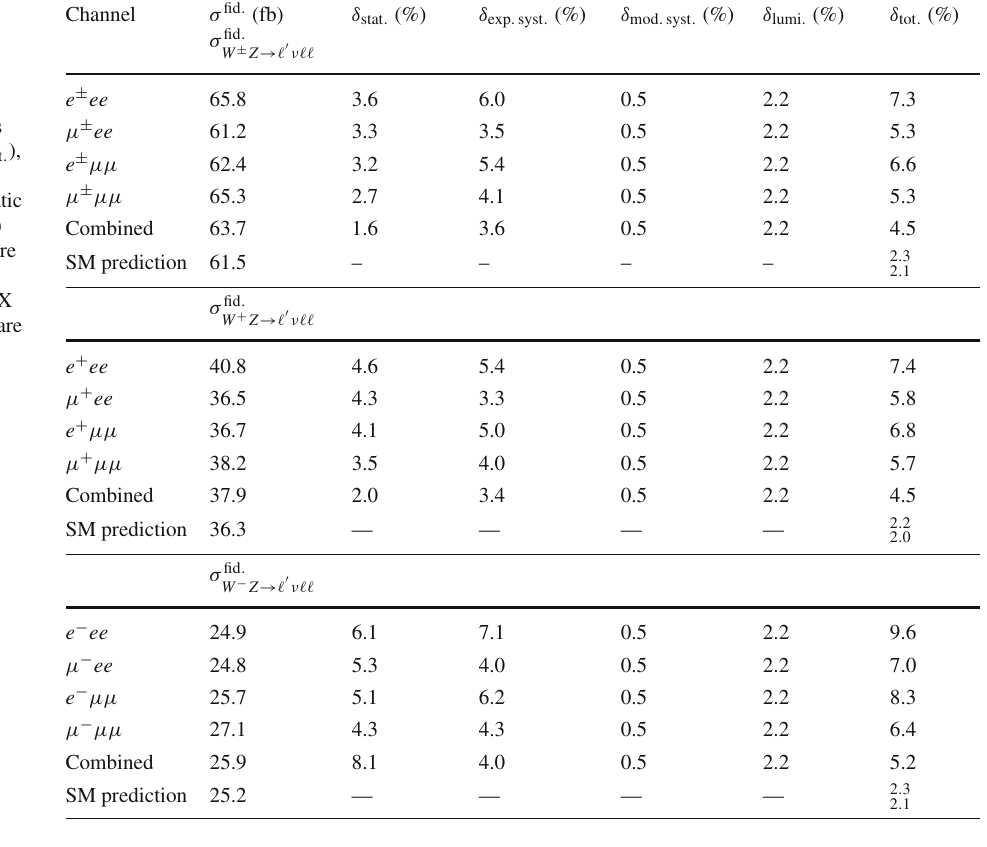
Table 4 Fiducial integrated